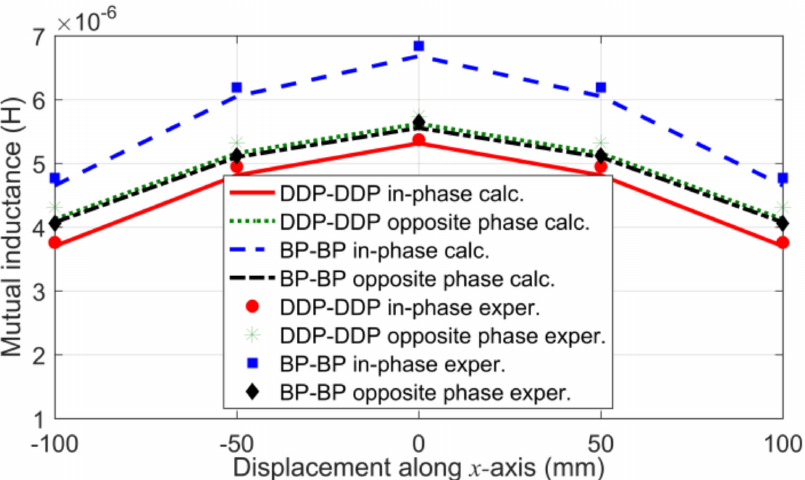
Figure 8. Experimental results and calculation results of mutual inductance for the two polarized couplers under misalignment along the x